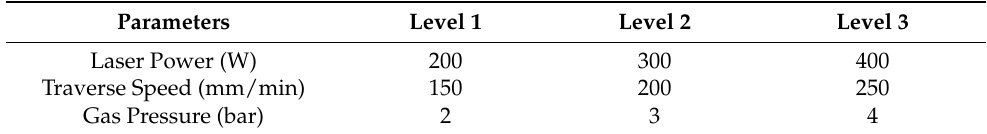
Table 1. Input parameters values for specimen thickness of 2 mm. Full thru cutting (FTC) parameters: 200 W laser power, 258 mm/min traverse speed, and 2 bar gas pressure.